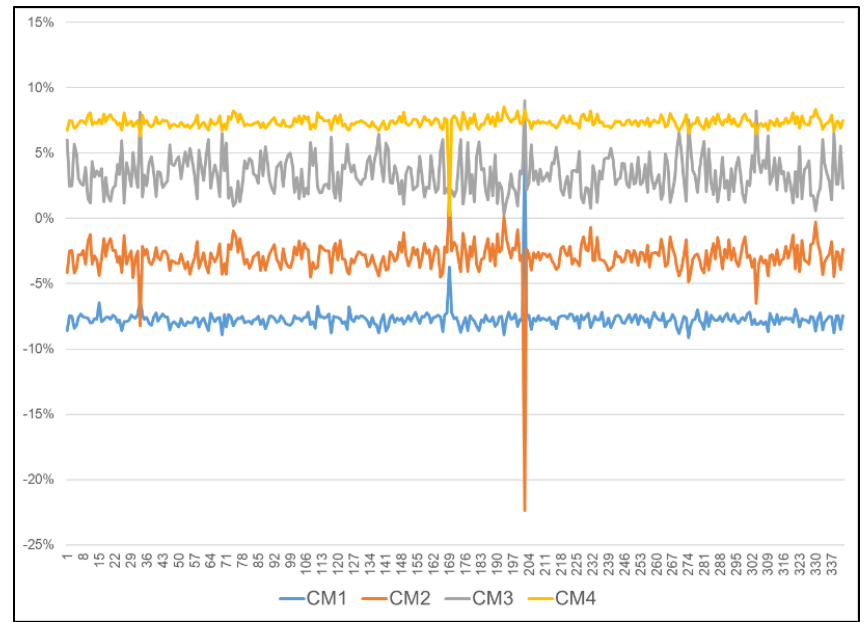
Figure 5. Difference between the DF contributions of each CMs.